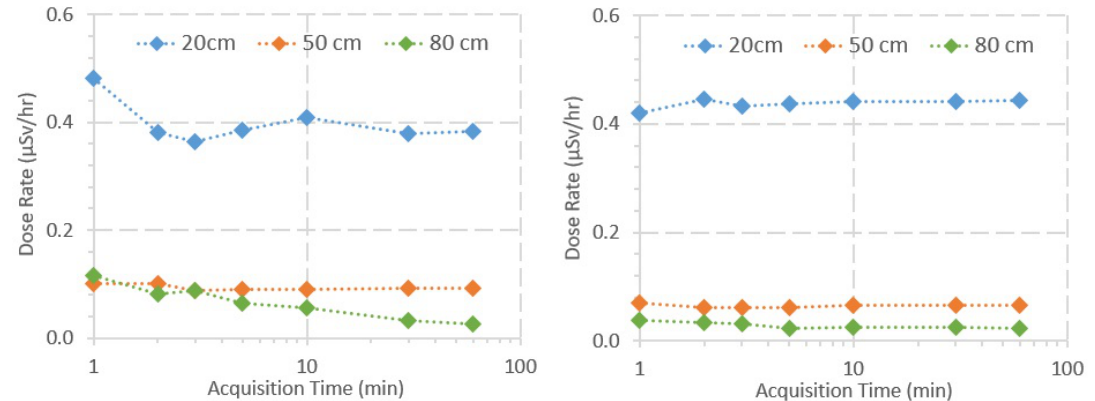
Figure 10. Dose rate as a function of the acquisition time for measurements using the Sparkfun ( left ) and the Mazur ( right ) at 20, 50, and 80 cm from two Cs-137